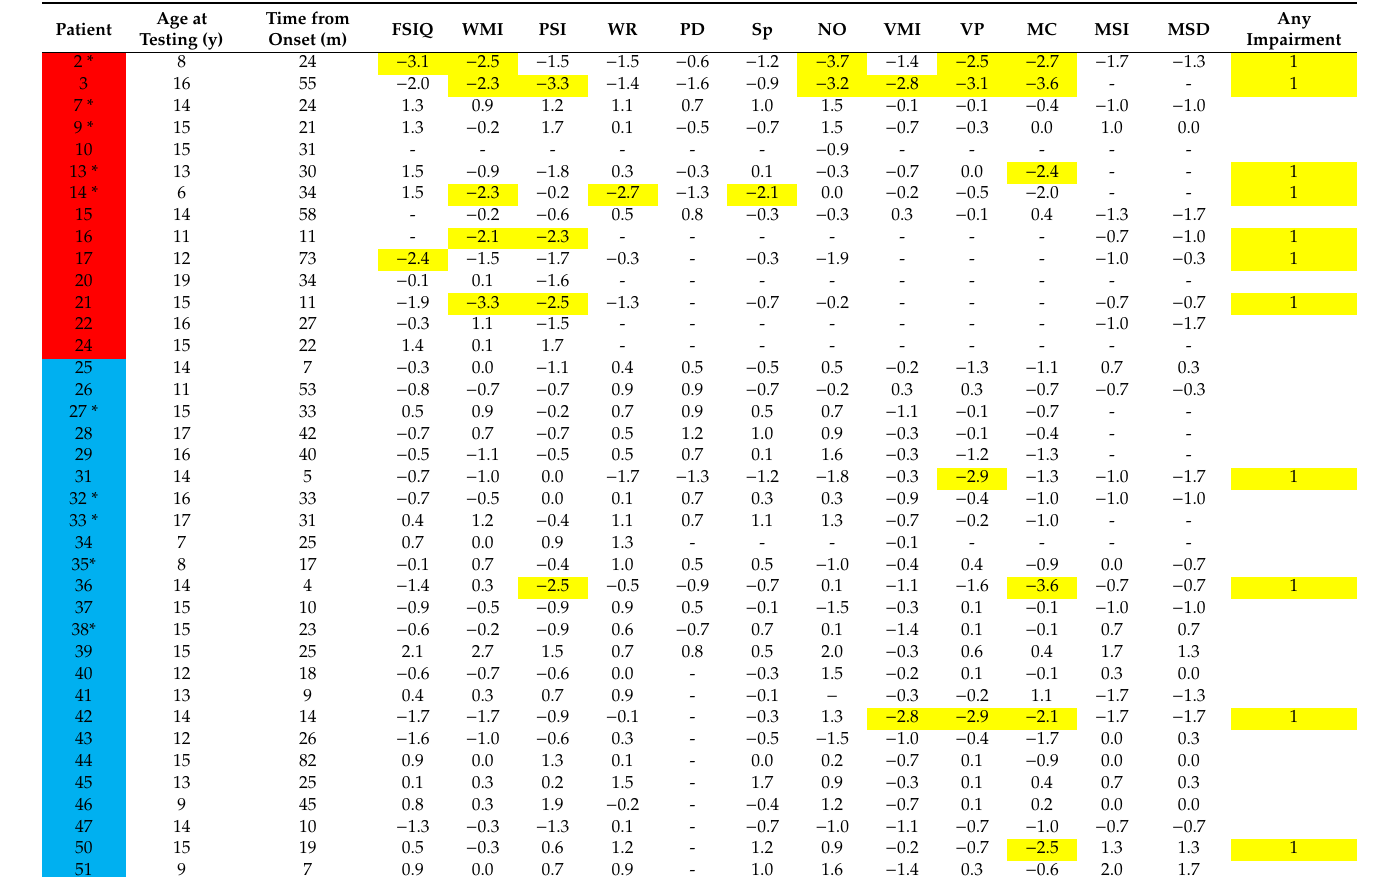
Table A1. Results of neurocognitive assessments highlighting cognitive di ffi